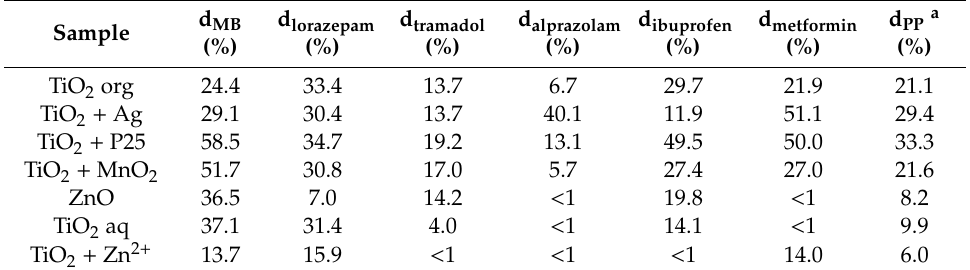
Table 3. Contributions of the di ff erent catalysts on the degradation of methylene blue and di ff erent pharmaceutical products after 4 h, minus the e ff ects of UVc only degradation and